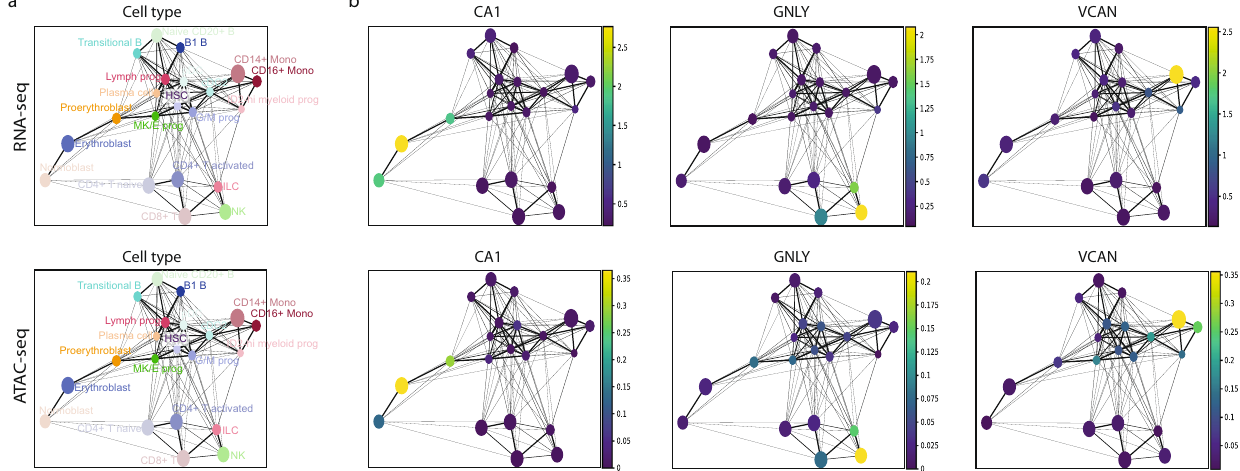
Fig. 3 Integration learned by sciCAN preserves hematopoietic hierarchy. a Co-trajectory analysis via PAGA using joint representation learned by sciCAN. Each dot is the sum of all cells annotated as the same cell type. Trajectory is visualized using RNA-seq (upper panel) and ATAC-seq (lower panel), separately. b Enrichments of signature genes for 3 different lineages using both RNA-seq (top) and ATAC-seq (bottom) data. Colorbar indicates gene expression (top) or gene activity level (bottom),